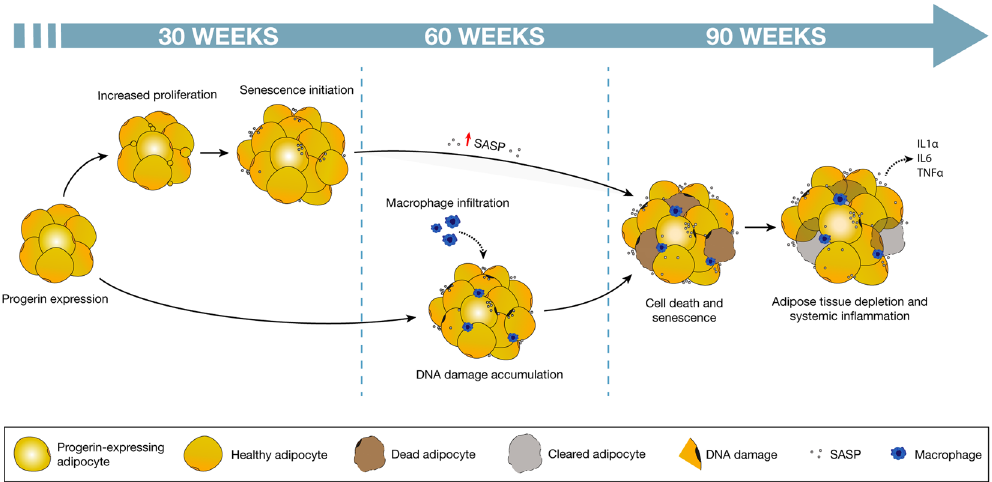
Figure 7. Proposed mechanism of adipose tissue depletion caused by low levels of progerin expression. Low frequency of progerin-expressing cells resulted in increased proliferation and initiation of senescence in 30 weeks RPE sWAT. At 60 weeks of age, the sWAT cells had accumulated DNA DSBs and macrophages had been infiltrating the tissue. At the last time point analyzed (from 90 weeks), cell death and senescence were increased, leading to tissue depletion and induction of systemic